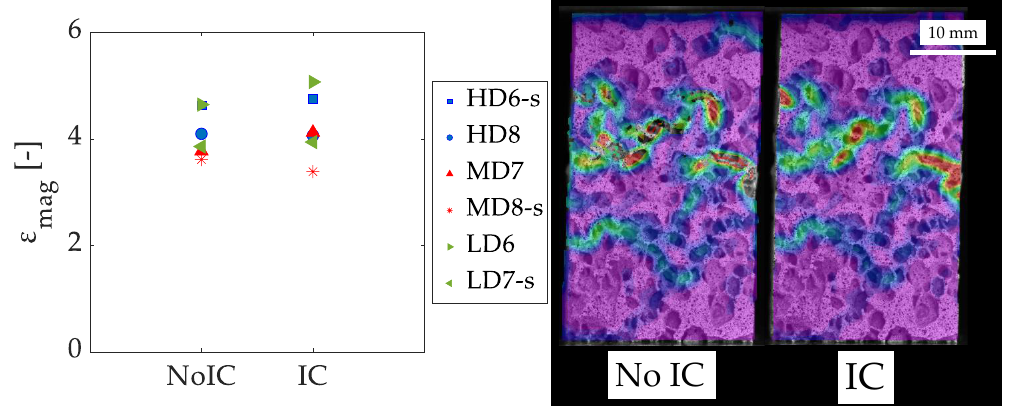
Figure 13. Equivalent strain magnification at the ultimate apparent point ( left ) and representation of the equivalent strain field ( right ) for incremental and non-incremental